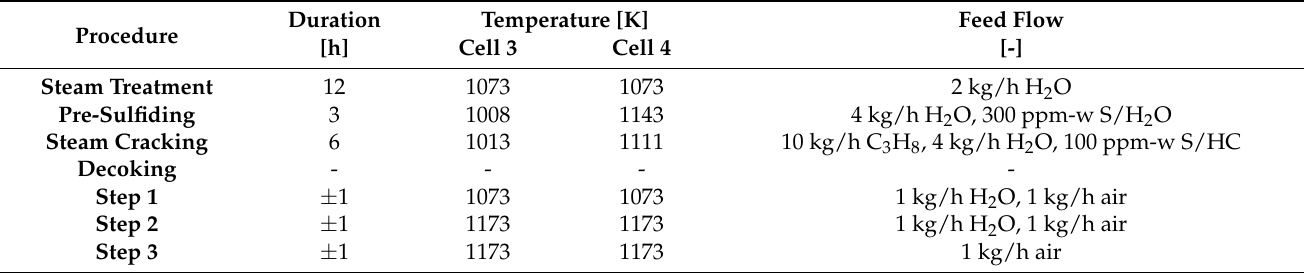
Table 2. Operating conditions for the steam cracking experiments.